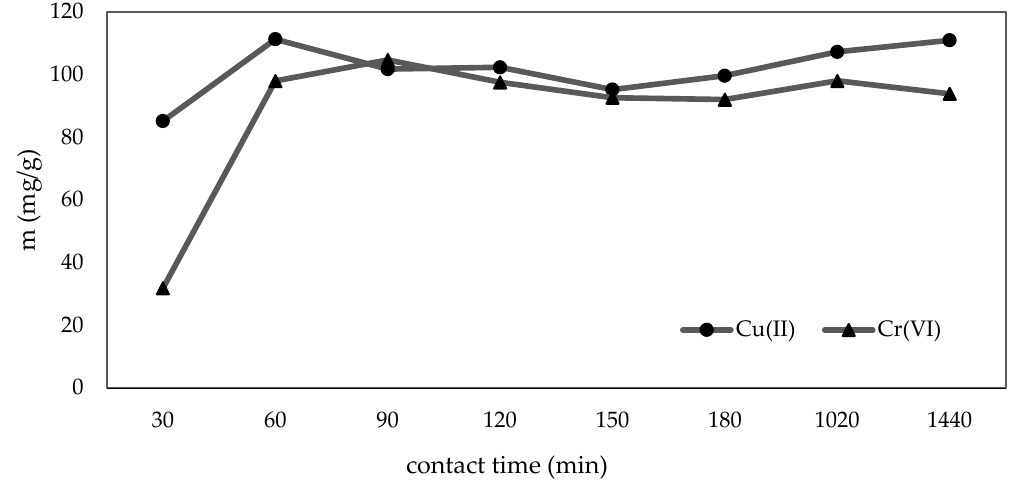
Figure 6. Effect of contact time on metal ions adsorption. (C-ZLCH: 0.01 g, volume: 50 mL, metal